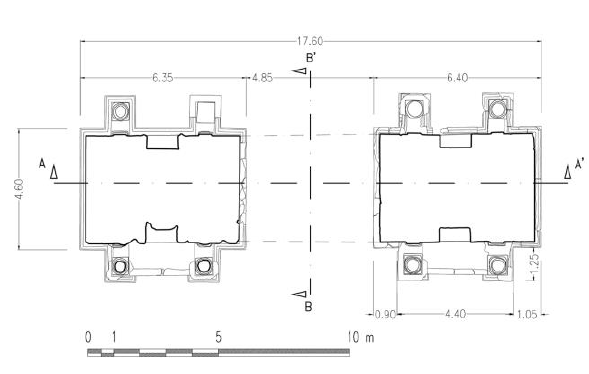
Figure 7. Plan (from the 2017 survey).